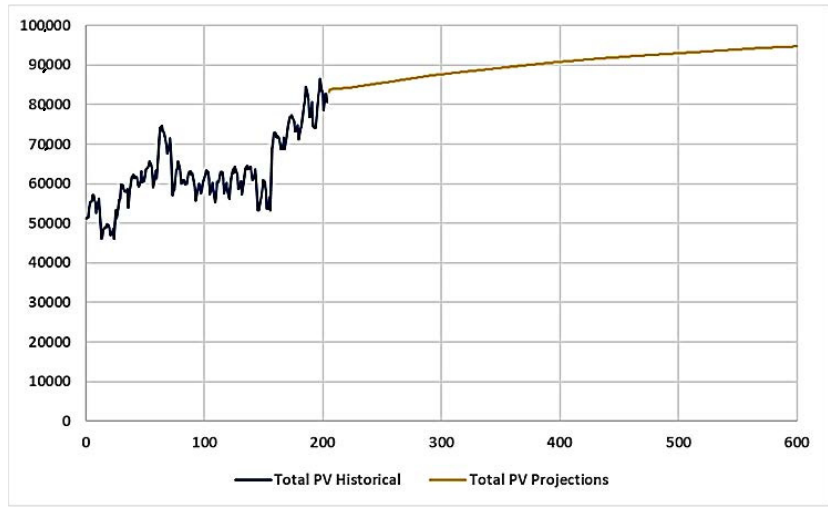
Figure 23. The PV traffic projections of case study 2.